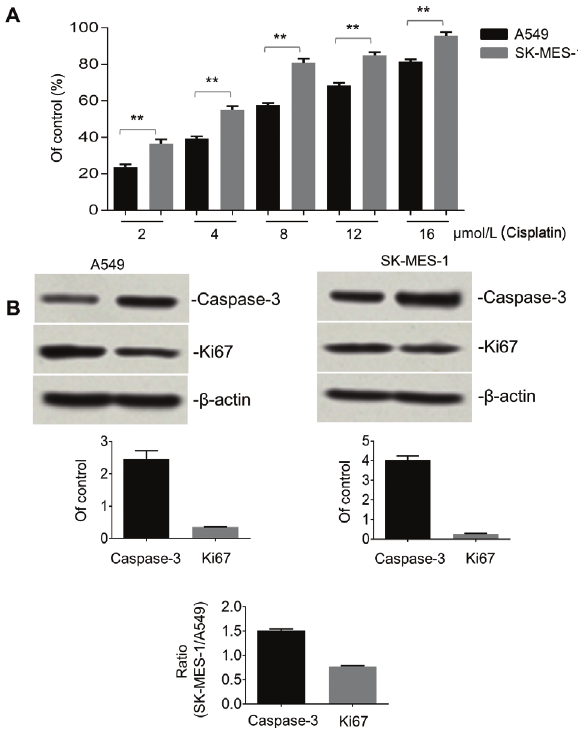
Fig. 3. The apoptosis rate of A549 was lower than that of SK-MES-1. A, the A549 and SK-MES-1 cell lines with the treatment of cisplatin (2, 4, 8, 12, and 16 μmol/L) were placed into 24-well plates and incubated with fresh medium. The apoptosis capacity of cells was determined by Flow cytometry. Data represent mean ± SD of three indepen- dent experiments ( P < 0.01). B, upper panel, the A549 and SK-MES-1 cell lines with the treatment of cisplatin (16 μmol/L) were placed on 6-well plates and incubated with fresh medium. The protein expression levels of caspase-3 and Ki67, and the internal control β -actin of A549 and SK-MES-1 cell lines were assessed by Western blotting. Protein expres- sion from three independent experiments. Quantitation by densitometry was shown on below ( P < 0.01). Lower panel, the extended expression of caspase-3 and Ki67 of A549 and SK-MES-1 cell lines is also detected.